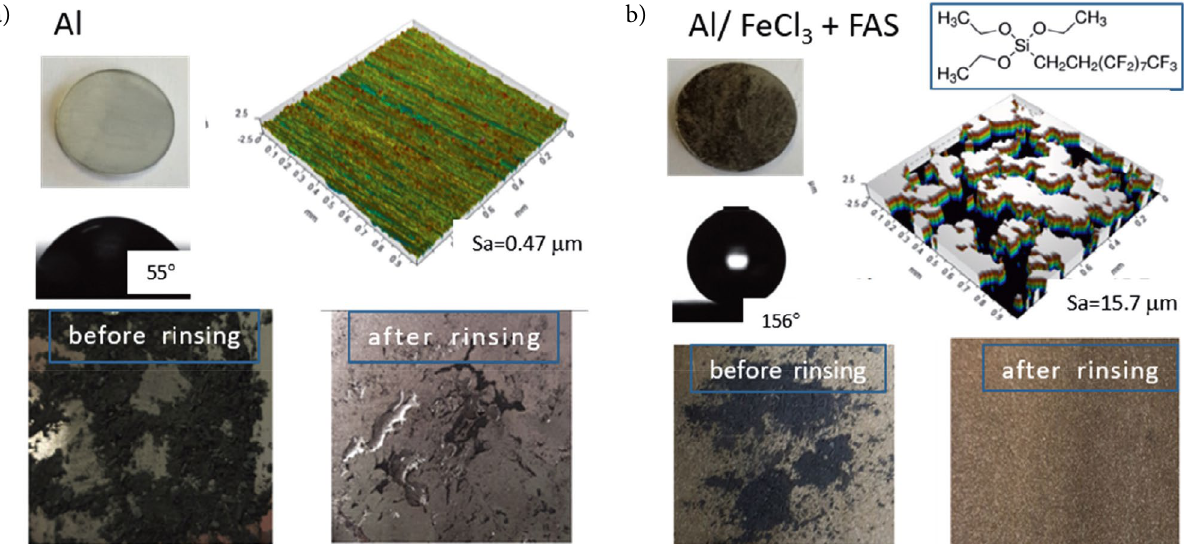
Figure 17. (a) Images of ground aluminium sample, water drop on its surface (contact angle 55°), 3-D topographical profile (mean surface roughness S a 0.47 µm) and images of sample covered with carbon particles simulating dirt before and after cleaning with water jet. (b) Images of ground alu- minium sample, etched using FeCl 3 and immersed in ethanol solution of FAS (perfluorodecyl triethoxysilane), water drop on its surface (contact angle 156°), 3-D topographical profile (mean surface roughness S a 15.7 µm) and images of sample covered with carbon particles simulating dirt before and after cleaning with water jet. Skeletal formula of FAS is given in (b).